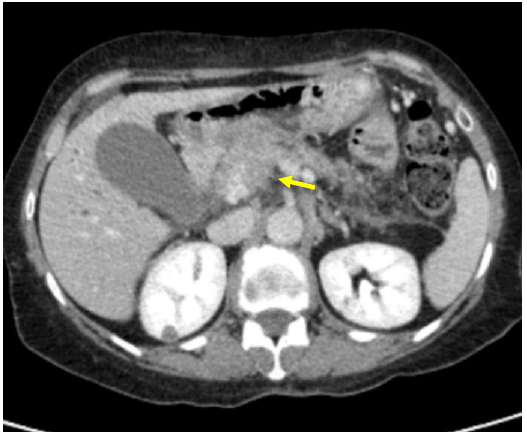
Figure 5. Pancreatic lesion with ill-defined margins (arrow) on CT examination in portal-venous contrast phase. Arterial invasion was detected in 74 (86.04%) metastatic patients and in 79 (39.11%) non-metastatic patients. Venous invasion was observed in 83 (96.51%) metastatic patients Table 2. Quantitative descriptors in metastatic (M+) and non-metastatic (M − ) patients. and in 98 (48.51%) non-metastatic patients. Visual lesion assessment in the portal-venous phase showed a significant statistical difference in the two groups, appearing hypodense, respectively, in 80 (93.02%) metastatic patients and 108 (53.46%) non-metastatic patients. Quantitative features are presented in Table 2.